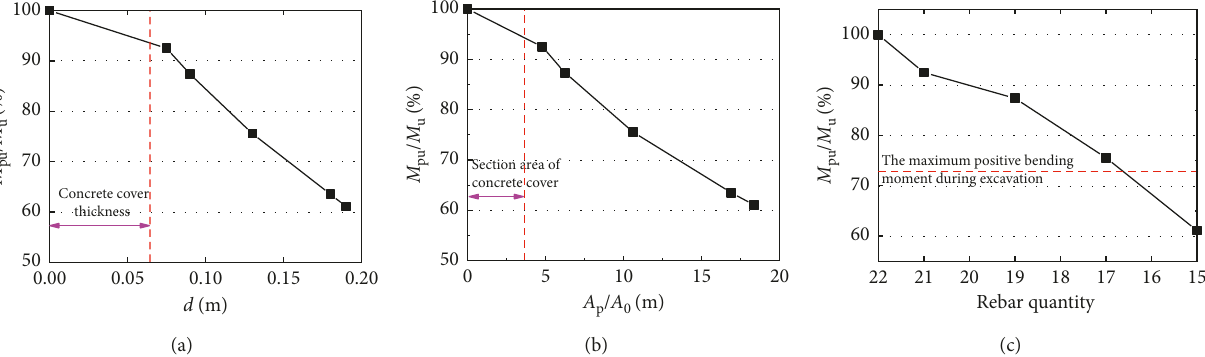
Figure 11: The flexural strength ratio curves with various excision region size. (a) Various radial excision distances; (b) various sectional area ratios of the excised pile to the completed pile; (c) various residual rebars